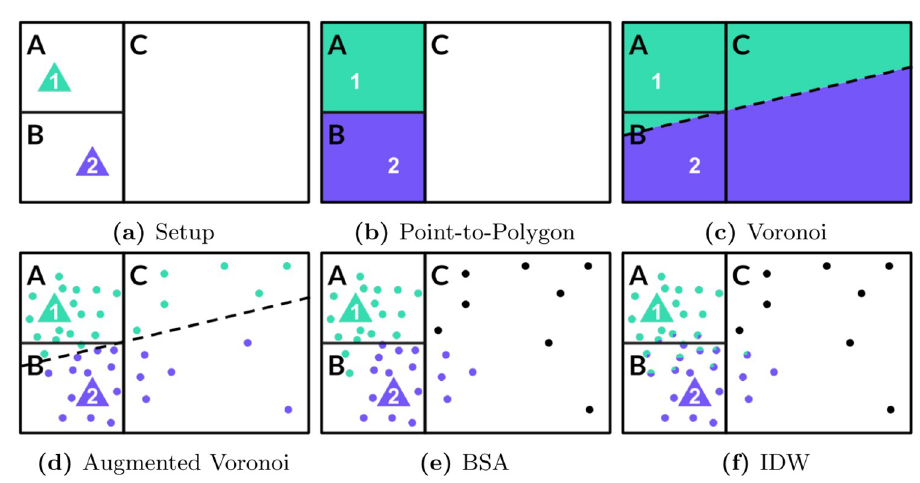
Fig 2. Popular and proposed mapping schemes. Three statistical areas (A-C), two BTS (1-2) and numerous dots representing built-up areas illustrate how different mapping schemes affect the allocation of BTS-level data to statistical data.